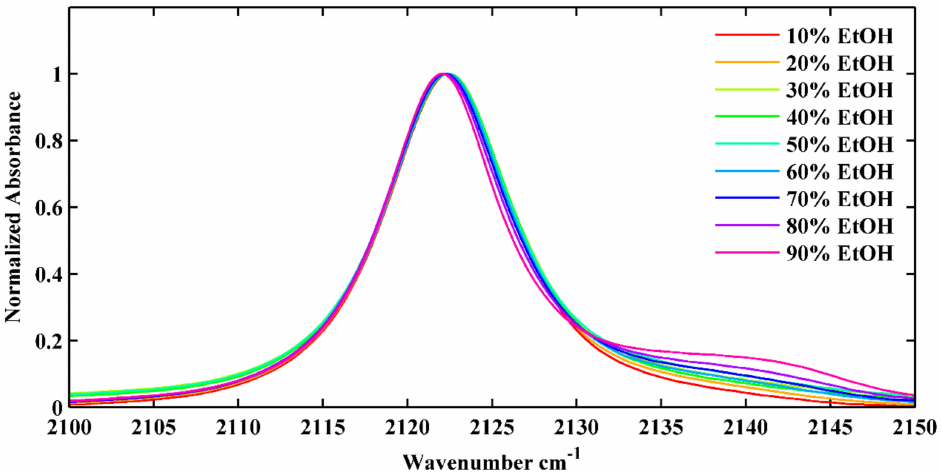
Figure 6. The NC stretching vibration of NM5ICI in DMSO and EtOH mixture with different volume ratios, as